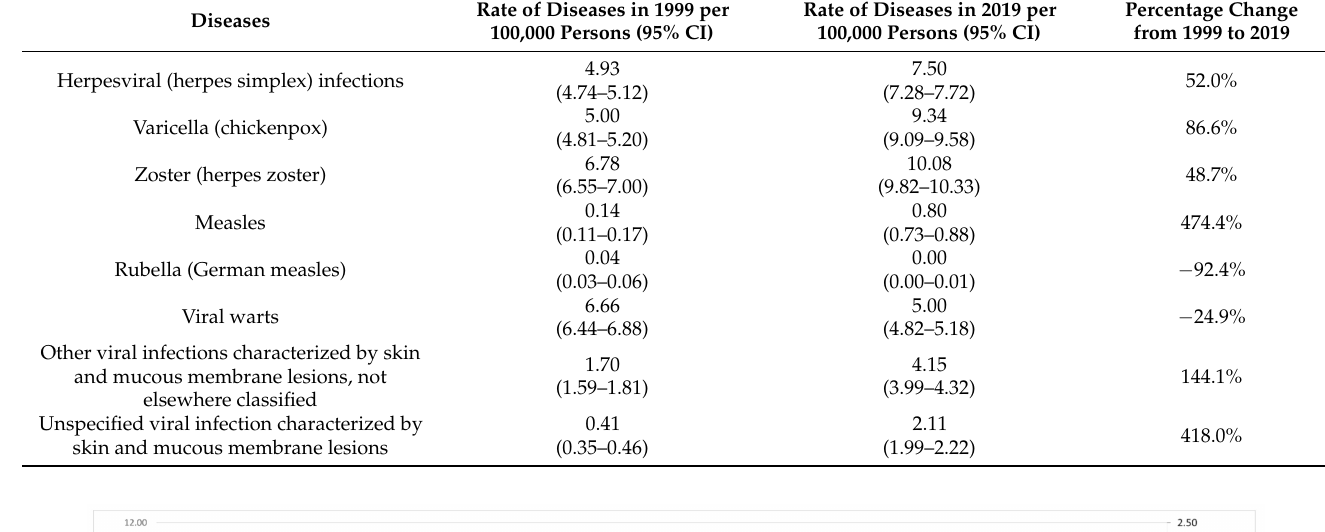
Table 2. Percentage change in the hospital admission rates from 1999 to 2019 in England and Wales.